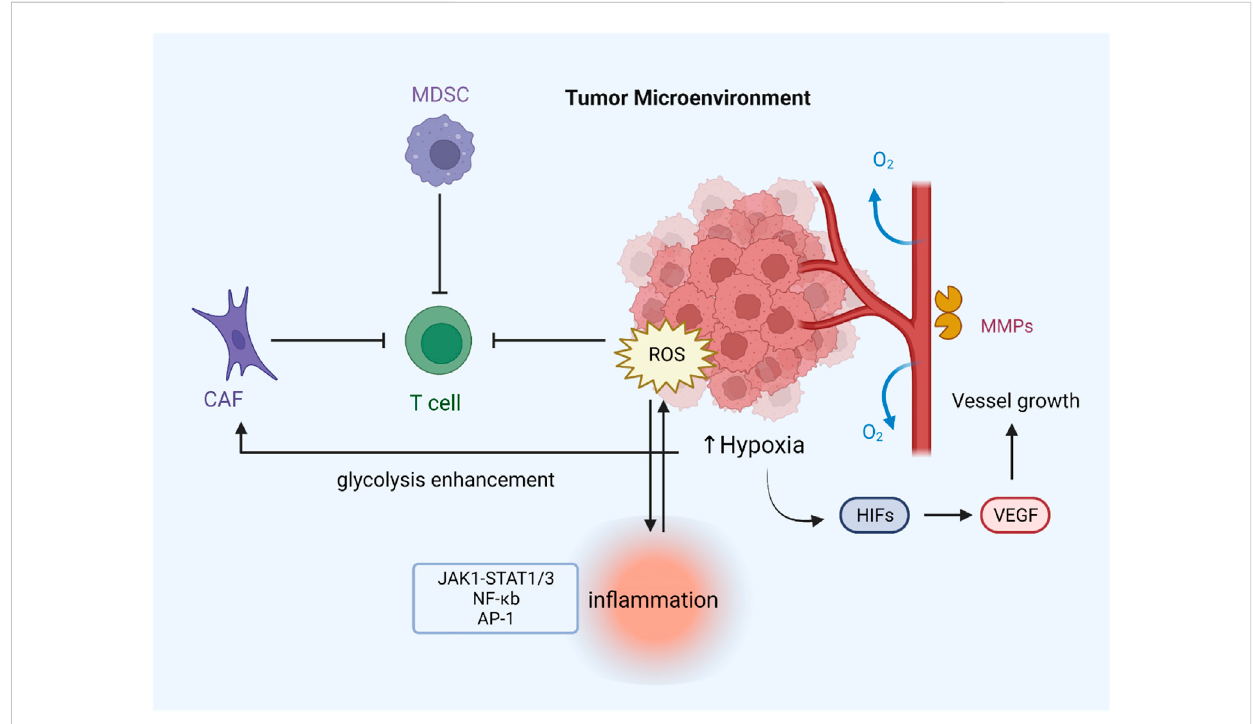
FIGURE 4 ROS regulate drug resistance by modulating the tumor microenvironment. Hypoxia can lead to ROS overproduction, which induces the expression of various angiogenic factors (VEGF) through the activation of HIF proteins, thereby promoting tumor angiogenesis. Increased release of MMP-1 contributes to the formation of vascular structures. MDSCs and CAFs can inhibit T-cell function by generating excessive ROS, thus leading to immune evasion of tumors. Increased ROS levels can also activate in fl ammation-related pathways and stimulate in fl ammasome